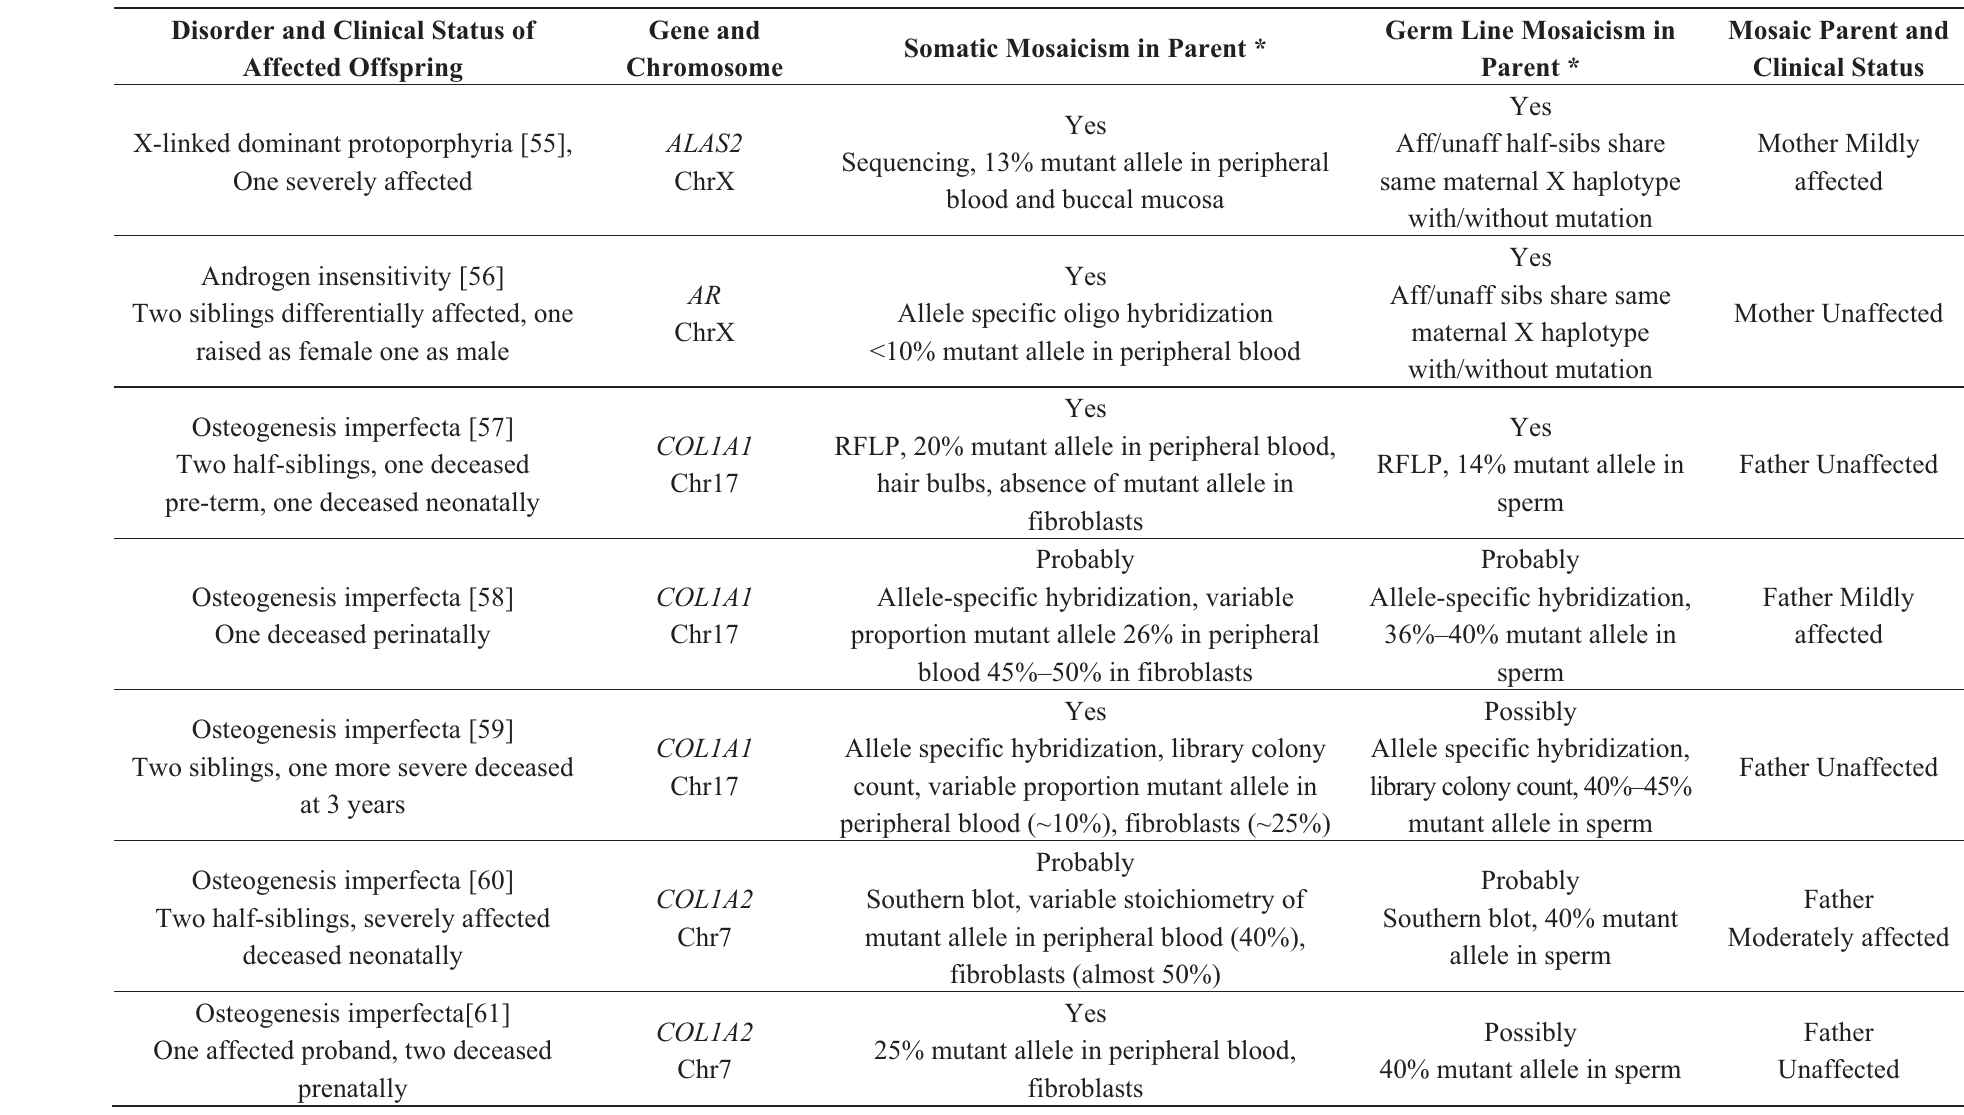
Table 1. Candidate examples of combined somatic and germ line mosaicism in genetic